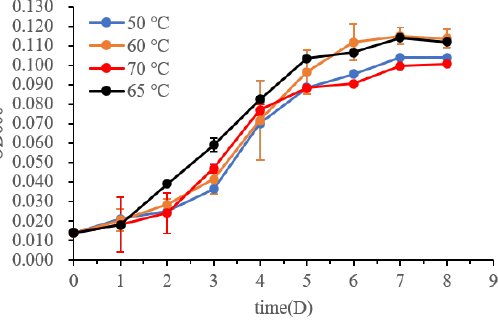
Figure 3. Growth curves of M. tengchongensis DL9LZB001 at different temperatures.